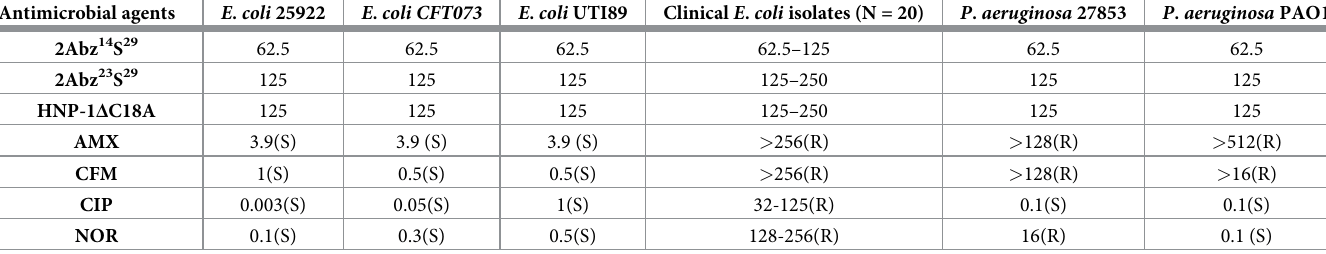
Table 2. Minimum Inhibitory Concentration (MIC) values of test peptides (2Abz 14 S 29 , 2Abz 23 S 29 , and HNP-1 Δ C18A) and antibiotics (amoxicillin, ciprofloxacin, cefixime, and norfloxacin) against standard and clinical E . coli isolates. Antimicrobial agents